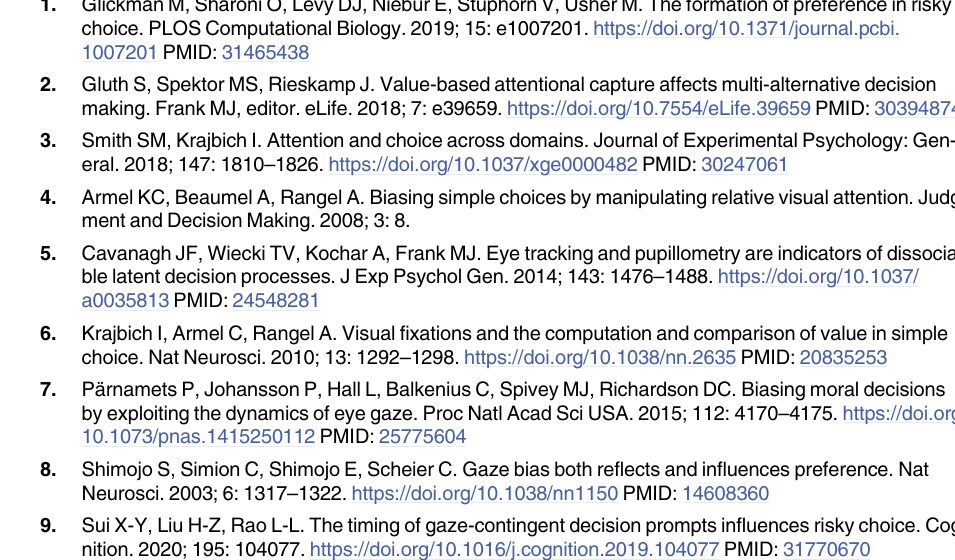
where model predicted choice probabilities are derived from a soft-max function over the final accumulator values, the comparison switch levels independent and comparative are not distin- guishable for a subset of the model space, reducing the total number of unique variants to 160. S3 Table. Overview of average best fitting model variants. All ten model variants that fit the data best on average used some form of gaze-dependence (blue shaded cells), mostly an alter- native-wise gaze discount. "n . d . " denotes variants where comparison mechanisms were not distinguishable by the